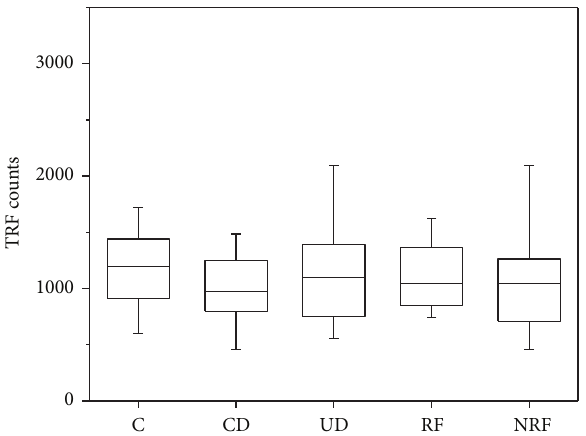
Figure 5: Urine CD81 level. Results from Time Resolved Fluores- cence assay. Kruskal-Wallis test: median TRF counts, 𝑝 = 0.5 at 𝛼 < 0.05 significance